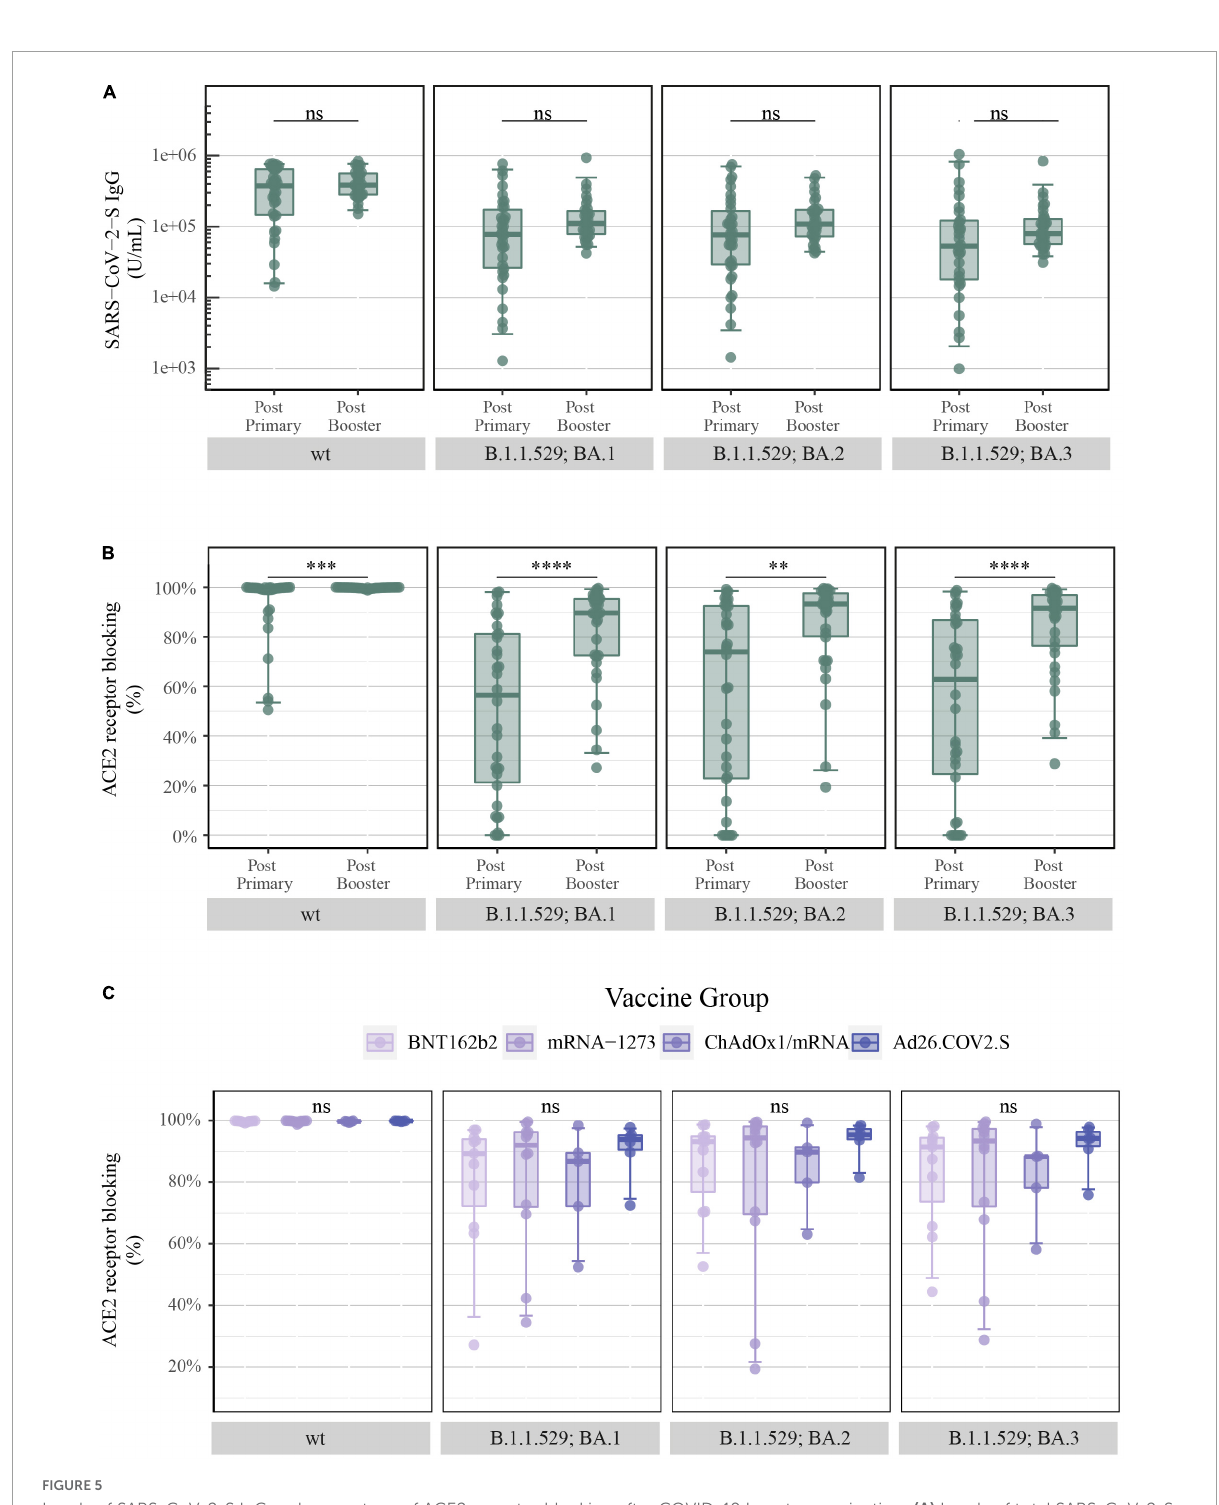
FIGURE5 Levels of SARS-CoV-2-S IgG and percentage of ACE2 receptor blocking after COVID-19 booster vaccination: (A) Levels of total SARS-CoV-2-S IgG in U/mL and (B) ACE2 receptor blocking in percentage at the third study visit (after primary vaccination) and at the Xc study visit (after booster vaccination) merged for all vaccine types quantified by the MSD platform (after primary = serum and after booster = plasma, IgG = 1:5,000 and ACE2 = 1:10). From left to right: SARS-CoV-2-S wt (Wuhan-Hu-1) and B.1.1.529; BA.1, BA.2 and BA.3 (Omicron). (C) ACE2 receptor blocking in percentage after booster vaccination with BNT162b2 ( n = 11), mRNA-1273 ( n = 12), ChAdOx1/mRNA ( n = 5) and Ad26.COV2.S/mRNA ( n = 6) quantified by the MSD platform (plasma 1:10). From left to right: SARS-CoV-2-S wt and B.1.1.529; BA.1, BA.2, and BA.3. All boxplots present the lower quartile, median and upper quartile, and the error bars indicate 95% CI. P -values were indicated as follows: ns = p > 0.05, ∗∗ p < 0.01, ∗∗∗ p < 0.001, and ∗∗∗∗ p <